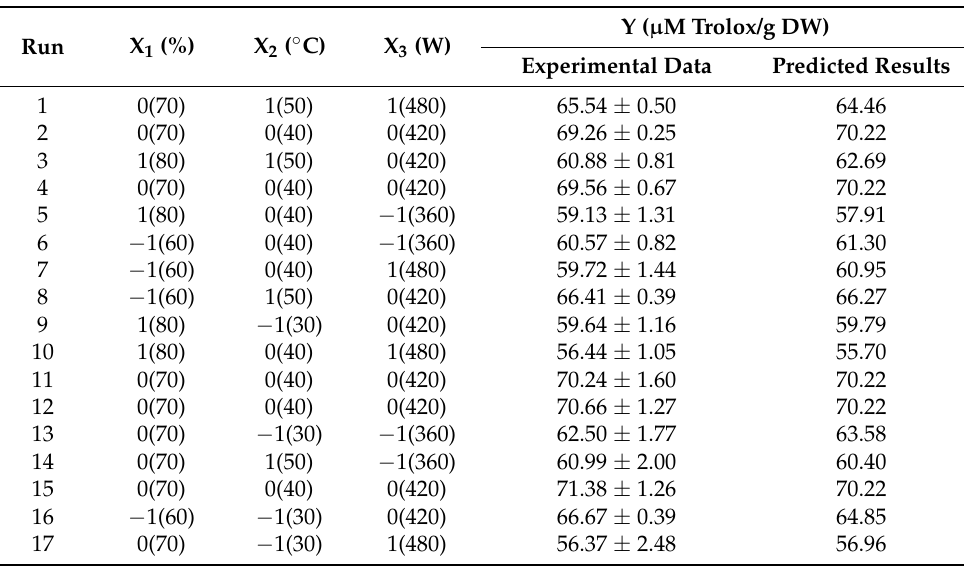
Table 2. Response surface design and ABTS values of the